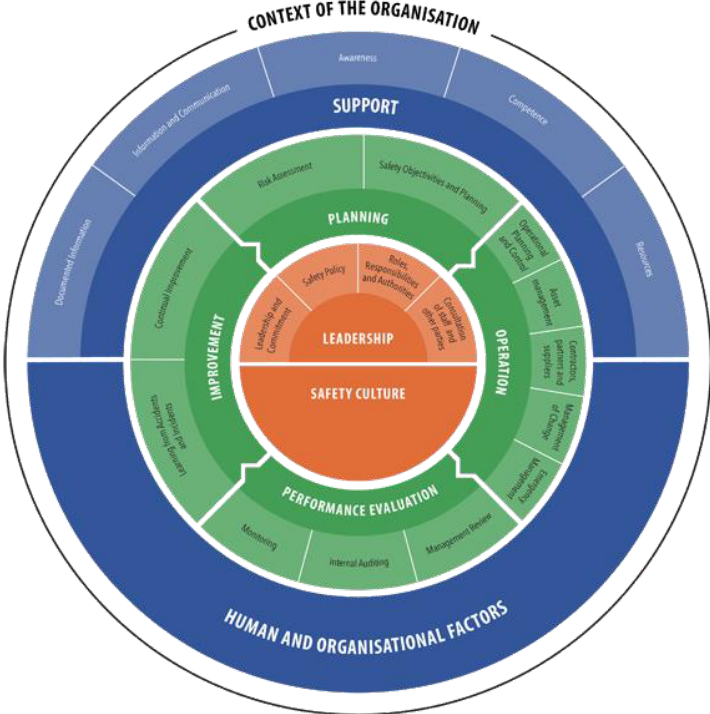
Figure 6. Safety Management Systems as of ERA